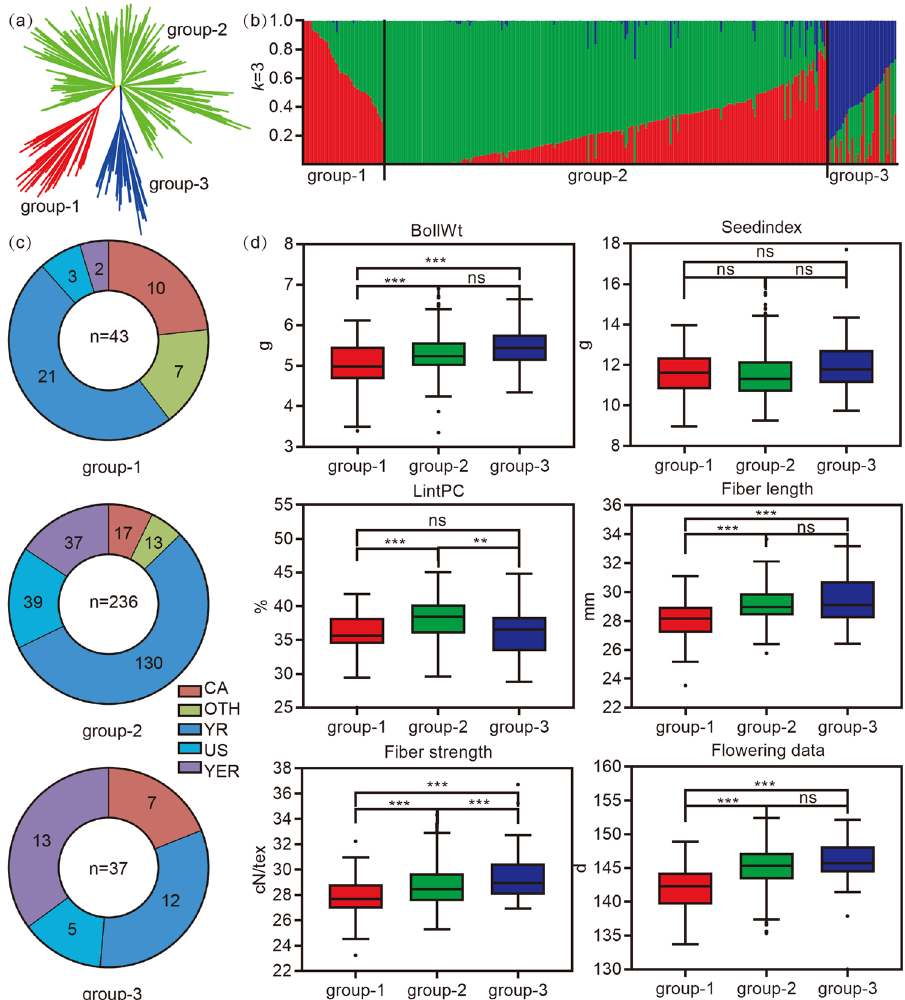
Figure 1. Phylogenetic relationships of 316 cotton accessions: ( a ) A neighbor-joining tree was constructed using whole-genome SNP data. The accessions were divided into three groups, group-1 (red), group-2 (cyan) and group-3 (blue); ( b ) Population structure of cotton accessions. The cotton samples were divided into three groups when k = 3; ( c ) Geographic origin of the three groups, Central Asia (CA), the United States (US), the Yellow River (YR), the Yangtze River (YZR) and other places (OTH); ( d ) Phenotype distributions of yield and fiber quality traits, the group divided by the structure of the 316 accessions, Boll weight (BW), Seed index (SI), Lint PC (LP), Fiber length (FL), Fiber strength (FS) and Flowering data (FD). Within boxplots, the bold line represents the median, box edges represent upper and lower quantiles, and whiskers are 1.5 times the quantile of the data. Outliers are shown as open dots (* P < 0.05, ** P < 0.01 and *** P < 0.001, two-sided t-test). The neighbor- joining tree ( a ) was constructed using the software PHYLIP (v3.696, https:// evolu tion. genet ics. washi ngton. edu/ phylip. html). Population structure of cotton accessions ( b ) was determined using the software Admixture (v1.30, http:// dalex ander. github. io/ admix ture/ index. html). The others were created by the software GraphPad Prism 9 (ver. 9.0.0, http:// www. graph pad.